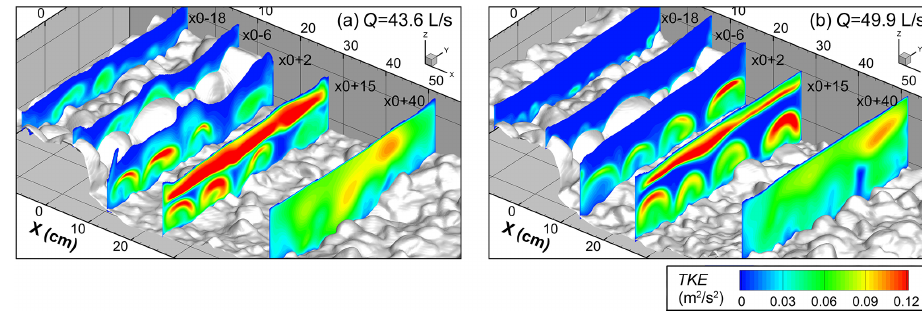
Figure 6. Distribution of the time-averaged turbulence kinetic energy (TKE) at the five cross-sections described in Fig.